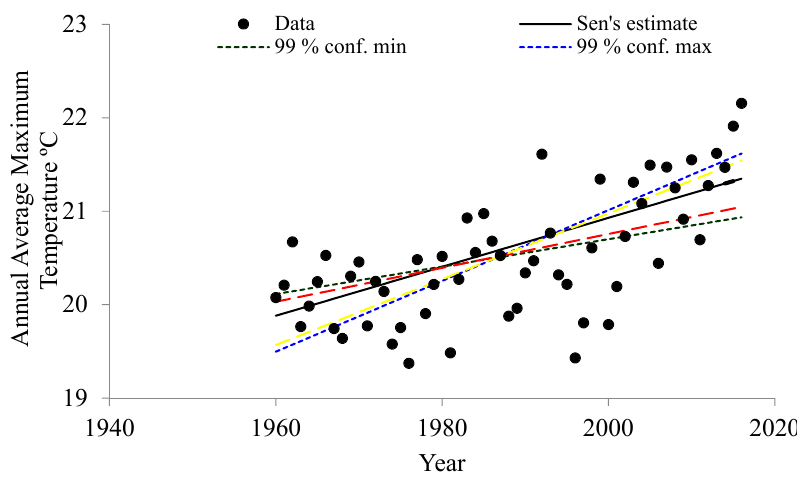
Figure 6. Mann–Kendall and linear regression slopes of annual average maximum temperature for Maloti-Drakensberg for the period of 1960–2016.